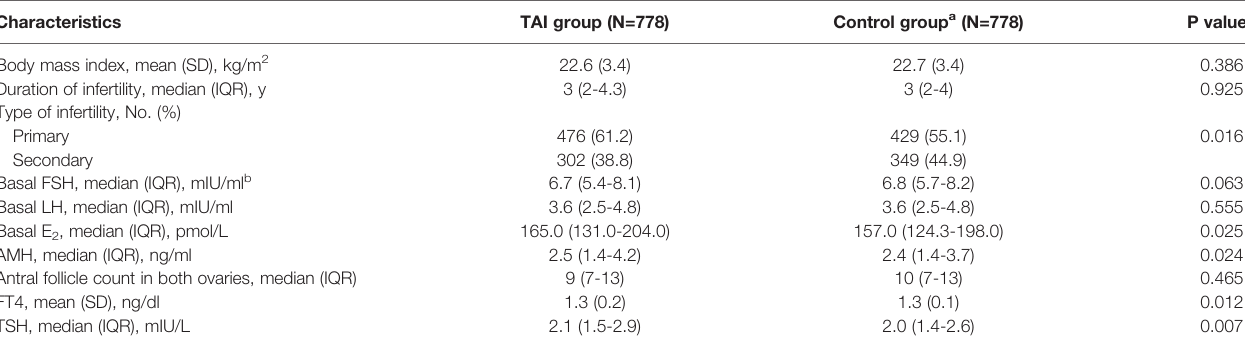
TABLE 1 | Baseline characteristics of